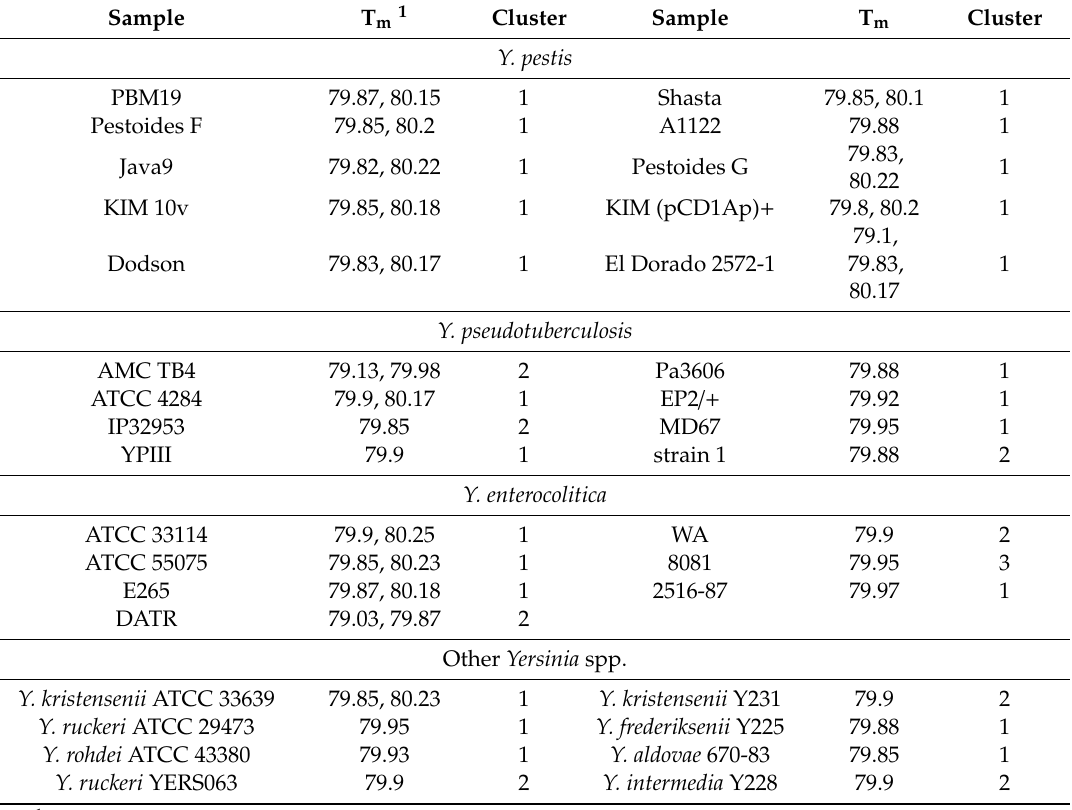
Table 6. GyrA melt temperatures and clusters for Yersinia spp. strains analyzed by